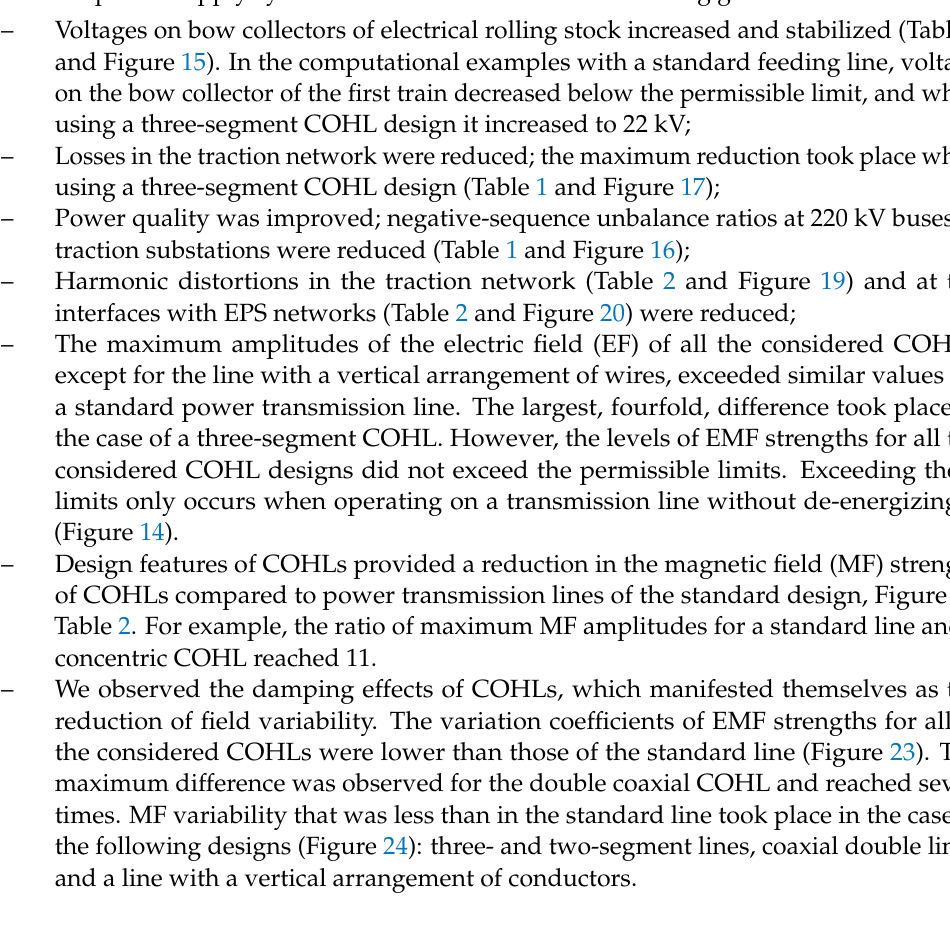
Figure 15. Voltage on the bow collector of the electric locomotive of the first train: 1 is a standard transmission line with AS - 600 conductors; 2 is with a vertical arrangement of conductors; 3 repre- sents a coaxial double - segment COHL; 4 is a coaxial four - segment COHL; 5 is a COHL with a delta arrangement of conductors; 6 is double coaxial COHL; 7 is a COHL with a parabolic arrangement of conductors; 8 is a COHL with a three - segment arrangement of conductors; 9 is a COHL with a concentric arrangement of conductors. Table 1. Extreme values of parameters. Transmission Line Design